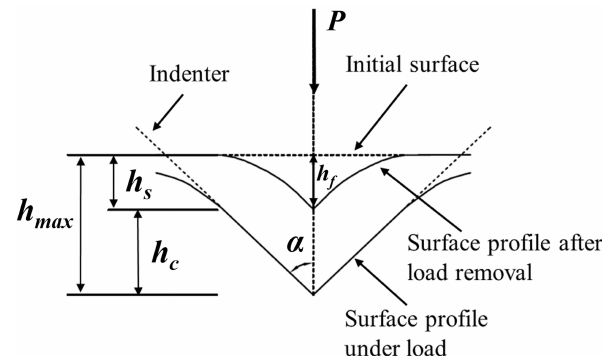
h max = h c + h s . The contact area of a perfect Berkovich in- denter can be computed as a function of h